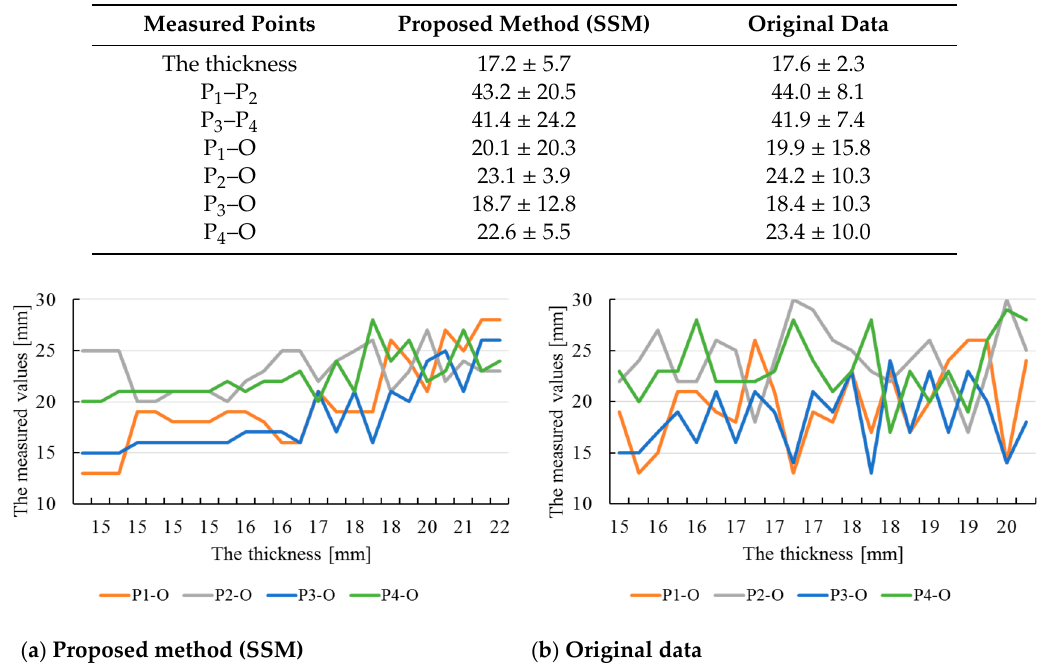
Table 1. The average and the variance of the measured values between di ff erent points on the humeral head (in mm).